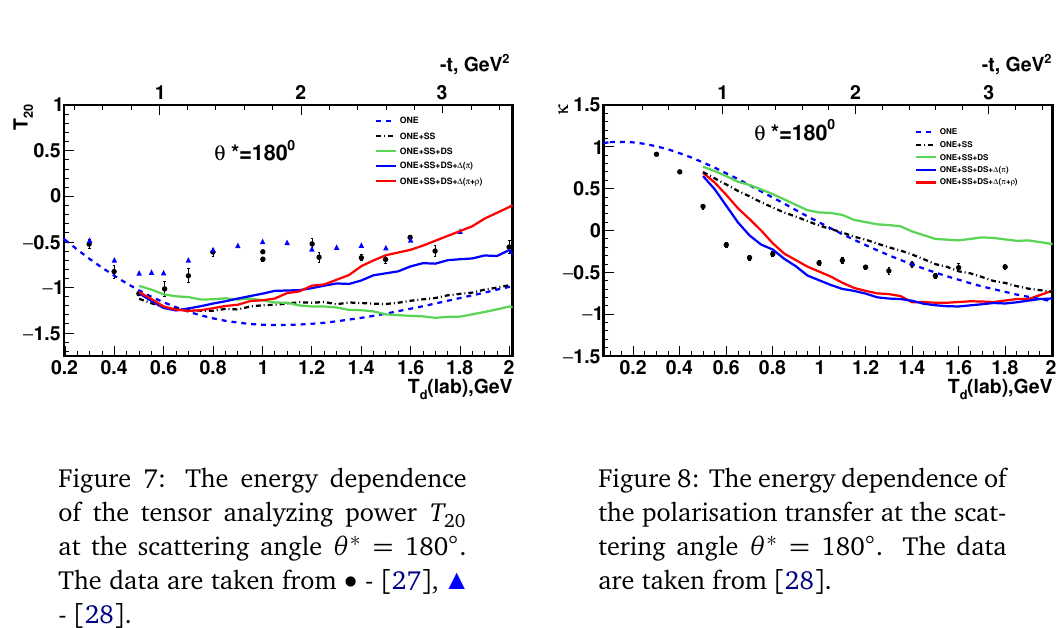
Figure 7: The energy dependence of the tensor analyzing power T at the scattering angle θ ∗ = 180 ◦ .